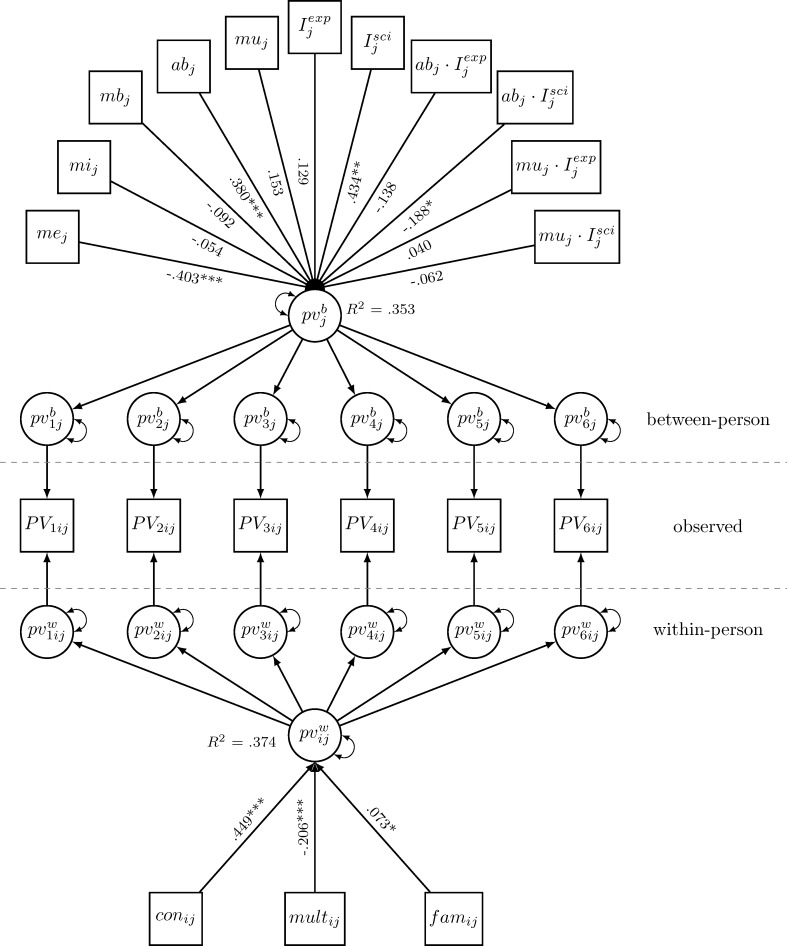
Standardized effects of confounders, topic-specific multiplism and the EBI-AM (M5).Note: χ2 = 181.307, df = 89, CFI = 0.96, TLI = 0.948, RMSEA = 0.027, SRMRwithin = 0.026, SRMRbetween = 0.047, ab = absolutism (EBI-AM); con = topic-specific consistency; Iexp = dummy variable contrasting the ‘expert statement’ with the ‘practitioner statement’ group; Isci = dummy variable contrasting the ‘scientific study’ with the ‘practitioner statement’ group; fam = topic familiarity; mb = benevolence (METI); me = expertise (METI); mi = integrity (METI); mu = multiplism (EBI-AM); mult = topic-specific multiplism; pv = perceived value of GPK for practice. *p < .05, **p < .01, ***p < .001.